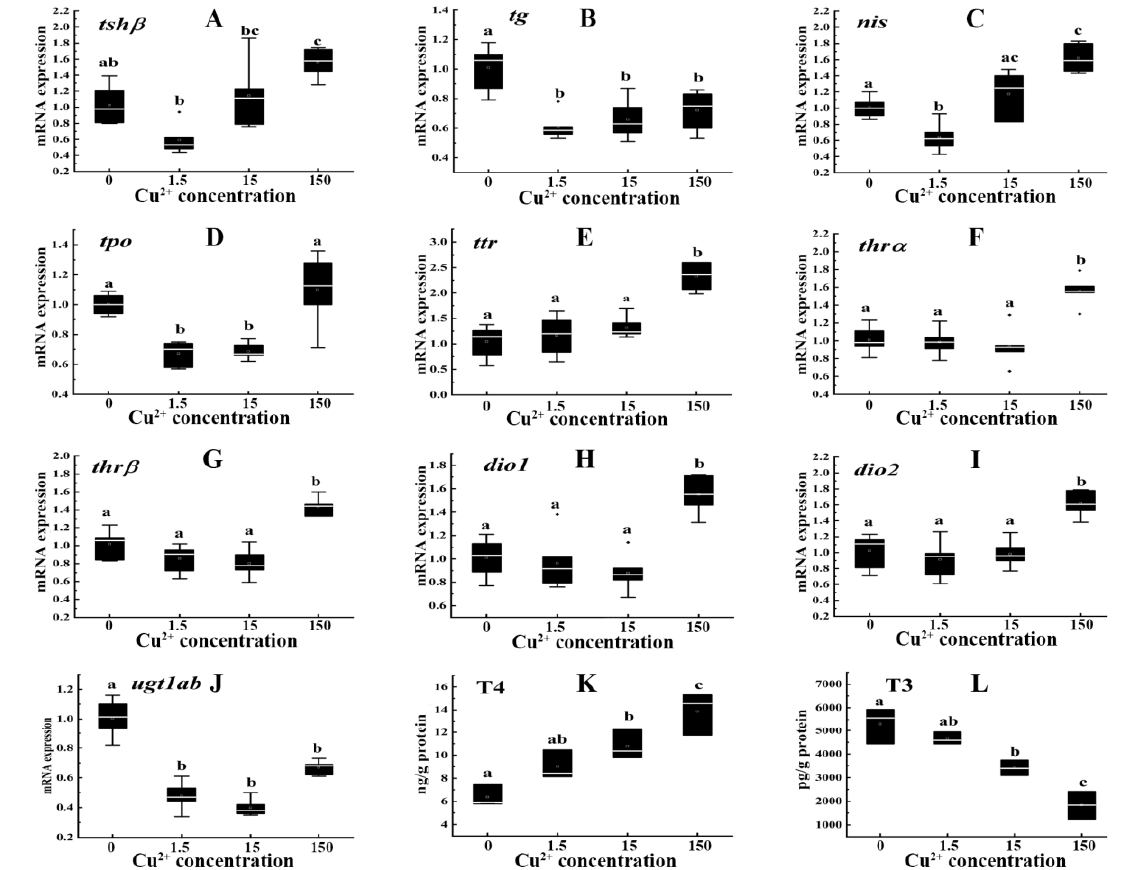
Figure 1. Transcription levels of tsh β ( A ), tg ( B ), nis ( C ), tpo ( D ), ttr ( E ), thr α ( F ), thr β ( G ), dio1 ( H ), dio2 ( I ), ugt1ab ( J ) and contents of T4 ( K ), T3 ( L ) in zebrafish embryos/larvae that were treated with Cu 2+ (0, 1.5, 15, and 150 μg/L) for 120 h. Data are shown as mean ± SD ( n = 6). Different letters denote the significant differences between groups.